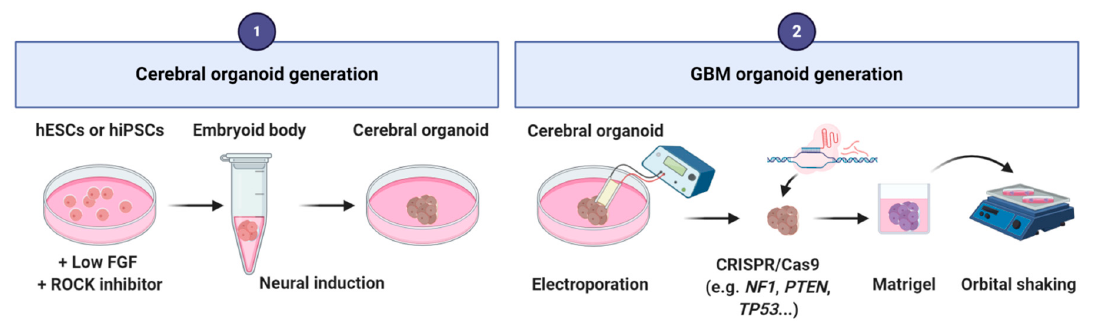
Figure 6. Main steps of the protocol for glioblastoma-derived from cerebral organoids generation.